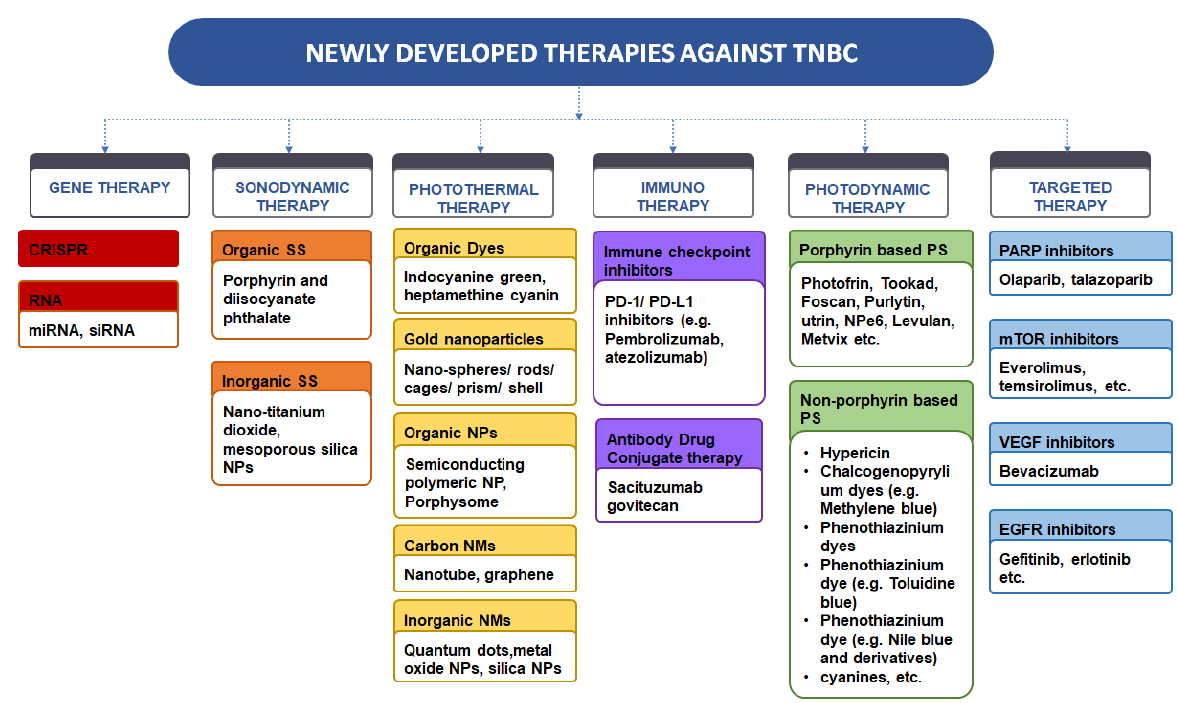
Figure 2. Newly developed therapeutic approaches for TNBC. CRISPR: Clustered Regularly Inter- spaced Short Palindromic Repeats; EGFR: Epidermal growth factor receptor; miRNA: Micro RNA; mTOR: Mammalian target of rapamycin; NM: Nanomaterials; NPs: Nanoparticles; PARP: Poly (ADP-ribose) polymerases; PD-1/PD-L1: Programmed death ligand 1; PS: Photosensitizer; RNA: Ri- bonucleic acid; siRNA: Small interfering RNA; SS: Sonodynamic sensitizers; VEGF: Vascular endo- thelial growth factor.